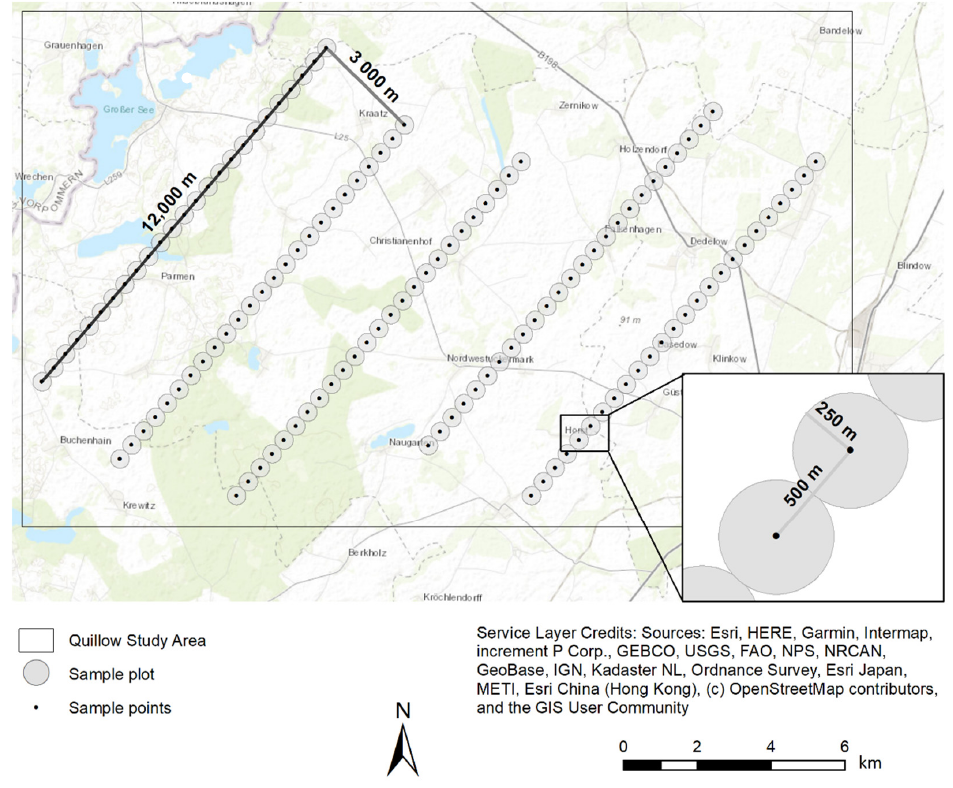
Figure 2. Arrangement of the sample plots for the bird observations within the Quillow catchment